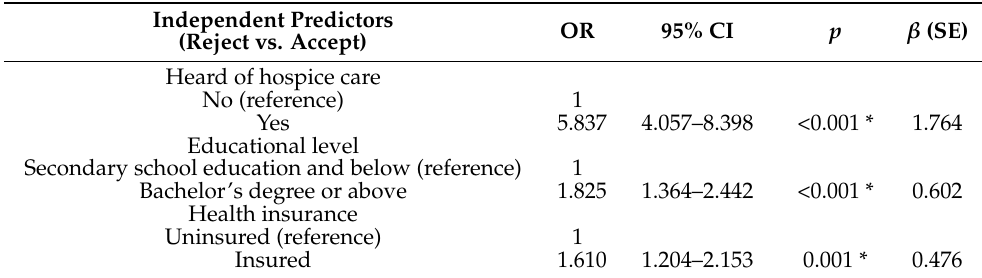
OR 95% CI p β (SE)